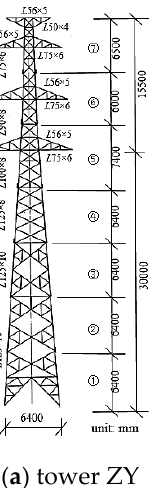
Figure 3. Transmission line towers and the wind loading.